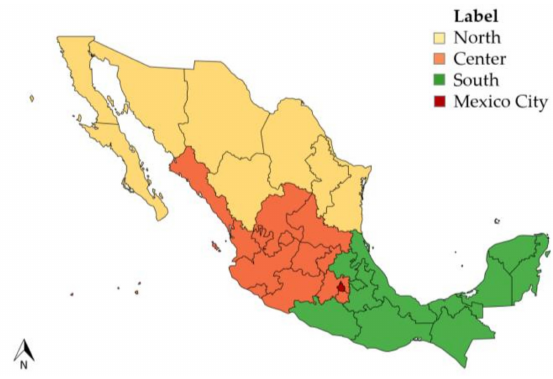
Figure 2. Mexico map by region